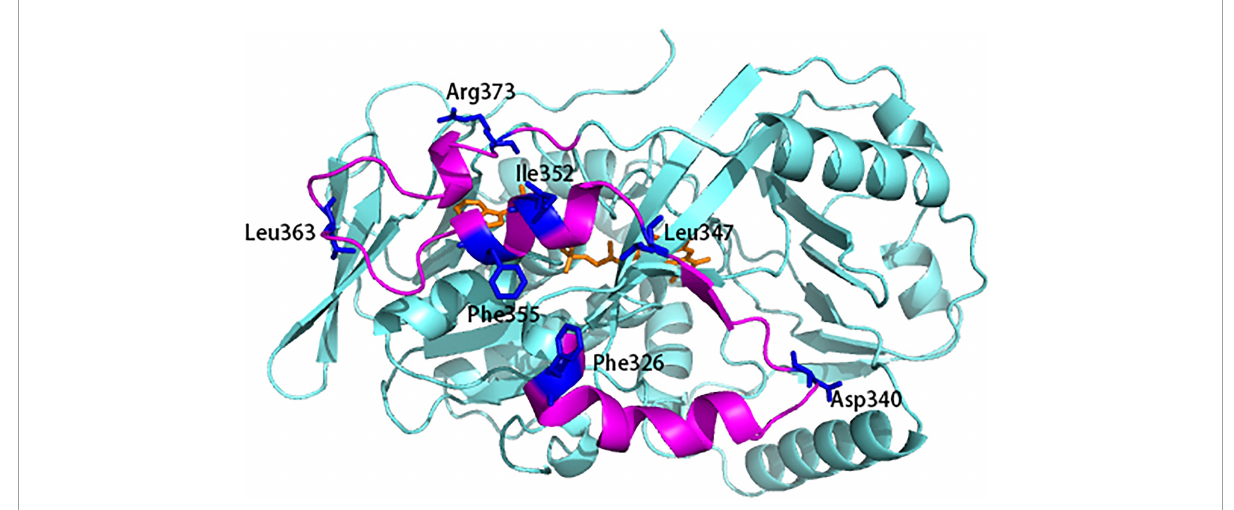
FIGURE1 The flexibility and potential residues chosen for site-saturation mutagenesis. The 3D model was based on the X-ray crystallographic structure of L -amino acid deaminase ( L -AAD) (PDB: 5hxw). Mutant sites were shown in